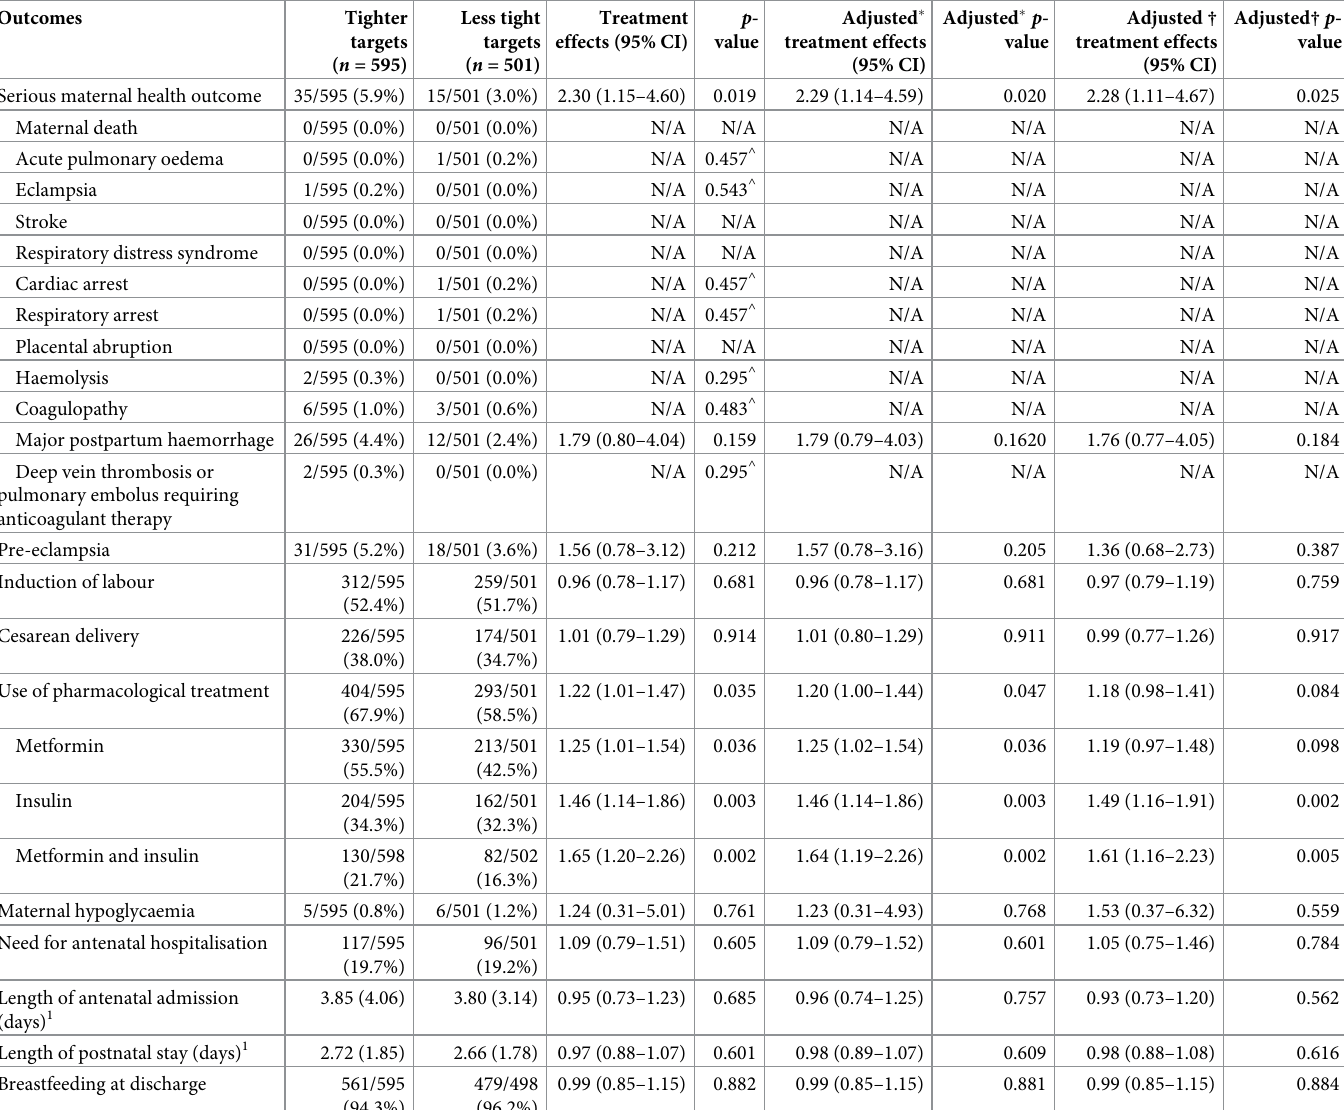
Table 4. Secondary outcomes for the